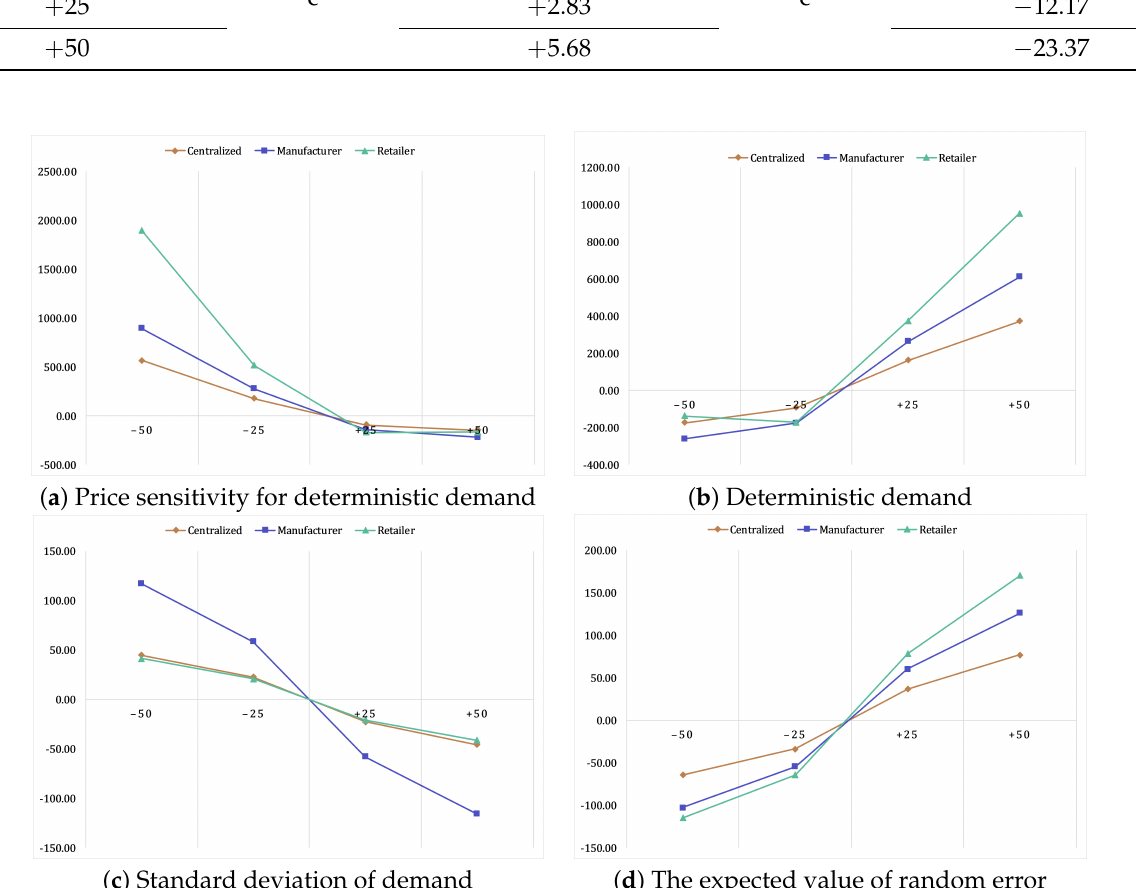
Figure 5. Graphical representation of sensitivity of demand